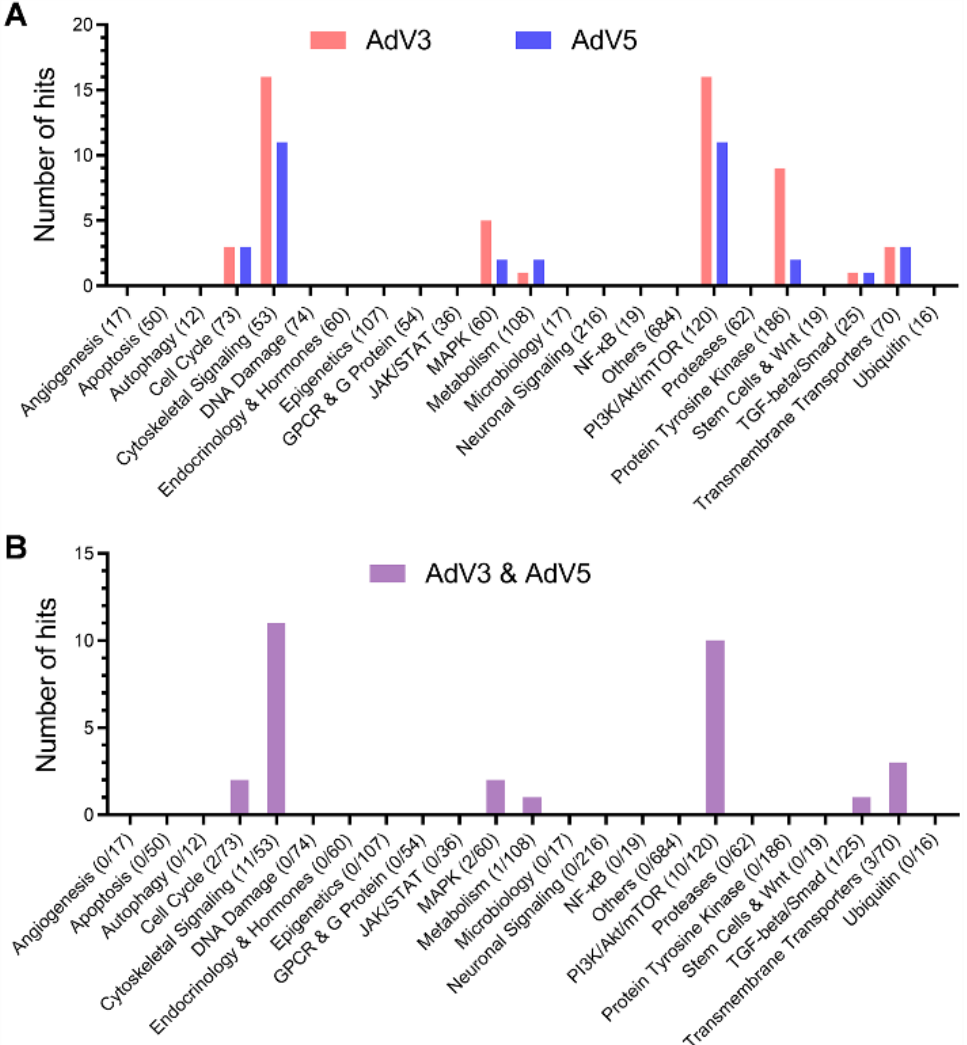
Figure 2. The secondary screening of the hits from the primary screen verifies the hits with dose- dependent antiviral activities. Vero cells were incubated with the serially diluted hit compounds from the primary screening for 10 min, followed by infection with AdV3 or AdV5 for 48 h. The viral replication levels were determined by IFA to detect hexon. The inhibition rates were calculated ac- cording to the methods in the anti-AdV activity assay. The cytotoxicity was measured by a cell via- bility assay using the CellTiter-Glo ® reagents over the serially diluted hit compounds. ( A ) The hit compound against AdV3 or AdV5 respectively categorizes the number of hits targeting each host factor or pathway in the secondary screening. ( B ) The number of hits inhibits both AdV3 and AdV5, targeting each host factor or pathway in the secondary screening. The ratio of hit number over the total compound number in each category is indicated in parentheses.